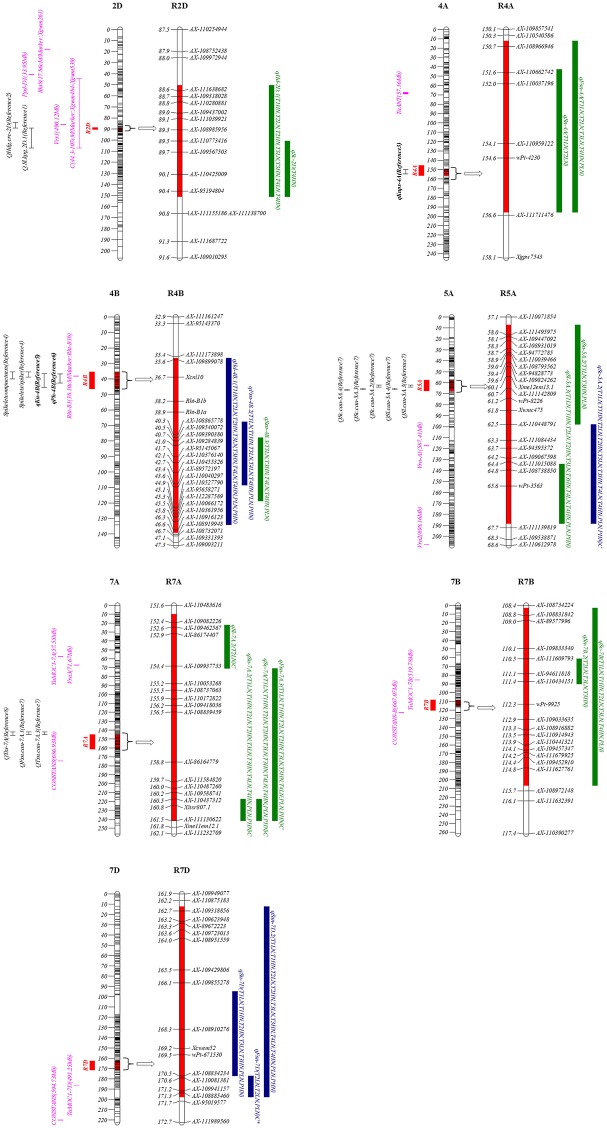
Chromosomal locations of seven highlighted genomic regions for spike characteristics in this study. The red intervals on the chromosomes and regions represent the LOD-3 confidence interval of the location of each genomic region. To the left of the chromosomes: the centiMorgan (cm) interval is shown; the red rectangles represent each QTL region; the purple lines represent the putative location of the screened genes associated with spike-related traits; the black intervals represent the coincident QTL in previous reports (Reference 1 to Reference 11), and among them, three QTL in bold (qKnps-4A, qPh-4B, and qKn-4B) were detected using the same population of this study (KJ-RILs). On the right of each chromosomal region: the blue and green rectangles represent the QTL with positive alleles from KN9204 and J411, respectively; the letter C after parentheses represents the expression of QTL induced by N deficiency, and among them, C* represents the QTL (qFsn-7D) is a completely LN-stress induced QTL. Reference 1: (Nishijima et al., 2017); Reference 2: (Cuthbert et al., 2008); Reference 3: (Cui et al., 2017); Reference 4: (Heidari et al., 2011); Reference 5: (Zhang et al., 2017); Reference 6: (Fan et al., 2015); Reference 7: (Zhai et al., 2016); Reference 8: (Xu et al., 2014).